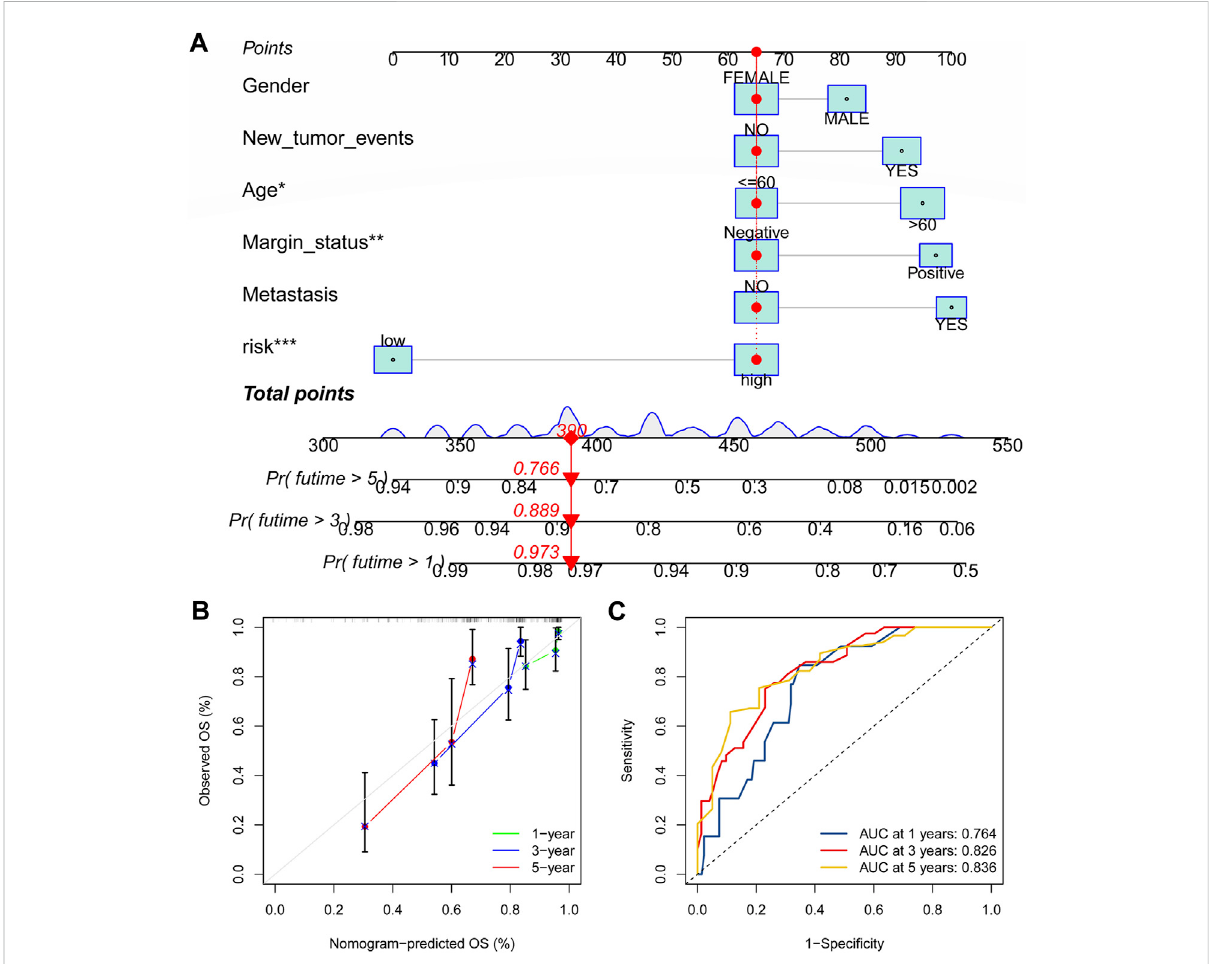
FIGURE 11 ConstructionofthenomogramforpredictingoverallsurvivalforSTS. (A) NomogrambasedonthenovelCRLncSiginforpredicting1-,3-,and5- yearoverallsurvivalofSTS. (B) Calibrationcurvesofthenomogram. (C) Theareaunderthetime-dependentROCcurvesfornomogramat1-,3-,and